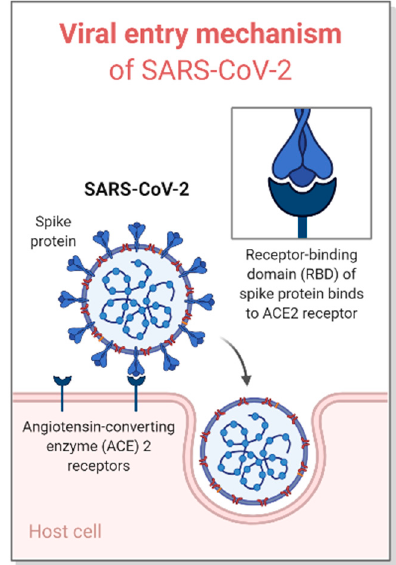
Figure 2. Viral entry mechanism of severe acute respiratory syndrome coronavirus 2 (SARS-CoV-2). SARS-CoV-2 first binds to ACE2 expressed in nasal epithelial cells or the respiratory tract and then penetrates into the target cell. Created with BioRender (https://biorender.com/) [16] .